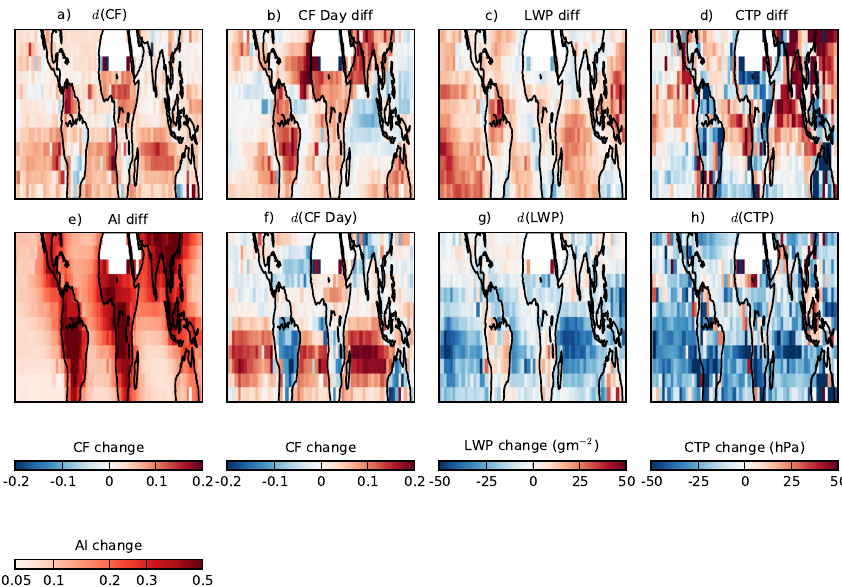
Fig. 5. The difference in end of timestep CF and AI between the low and high AI populations (a) and the difference in AI between the highest and lowest AI quartiles (e) for the shallow cumulus regime. The difference in CF Day (MODIS cloud mask), Liquid Water Path – Liquid clouds and Cloud Top Pressure at the start of the timestep (b–d) , and the difference in the evolution of these quantities over the timestep (f–h) . These plots all use MODIS Aqua and Terra data from 2003–2011, between 30 ◦ N and 30 ◦